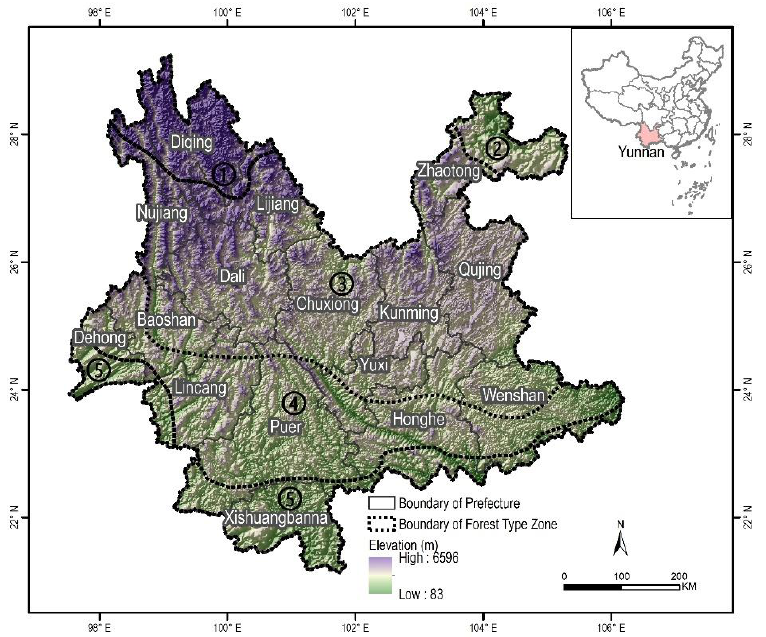
Figure 1. The location of Yunnan Province in China, topography and forest type zones: ① cold- temperate coniferous forest, ② warm evergreen broadleaved forest, ③ warm evergreen broadleaved and coniferous forest, ④ warm – hot broadleaved and coniferous forest and ⑤ tropical broadleaved forest.